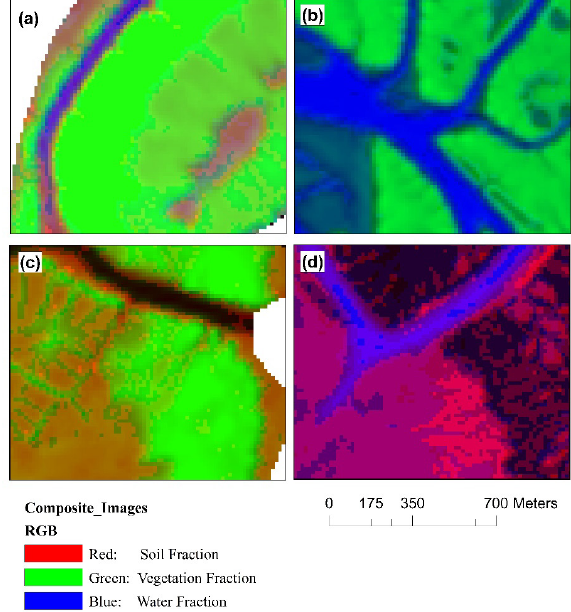
Figure 7. RGB displays of (vegetation, water, and soil)